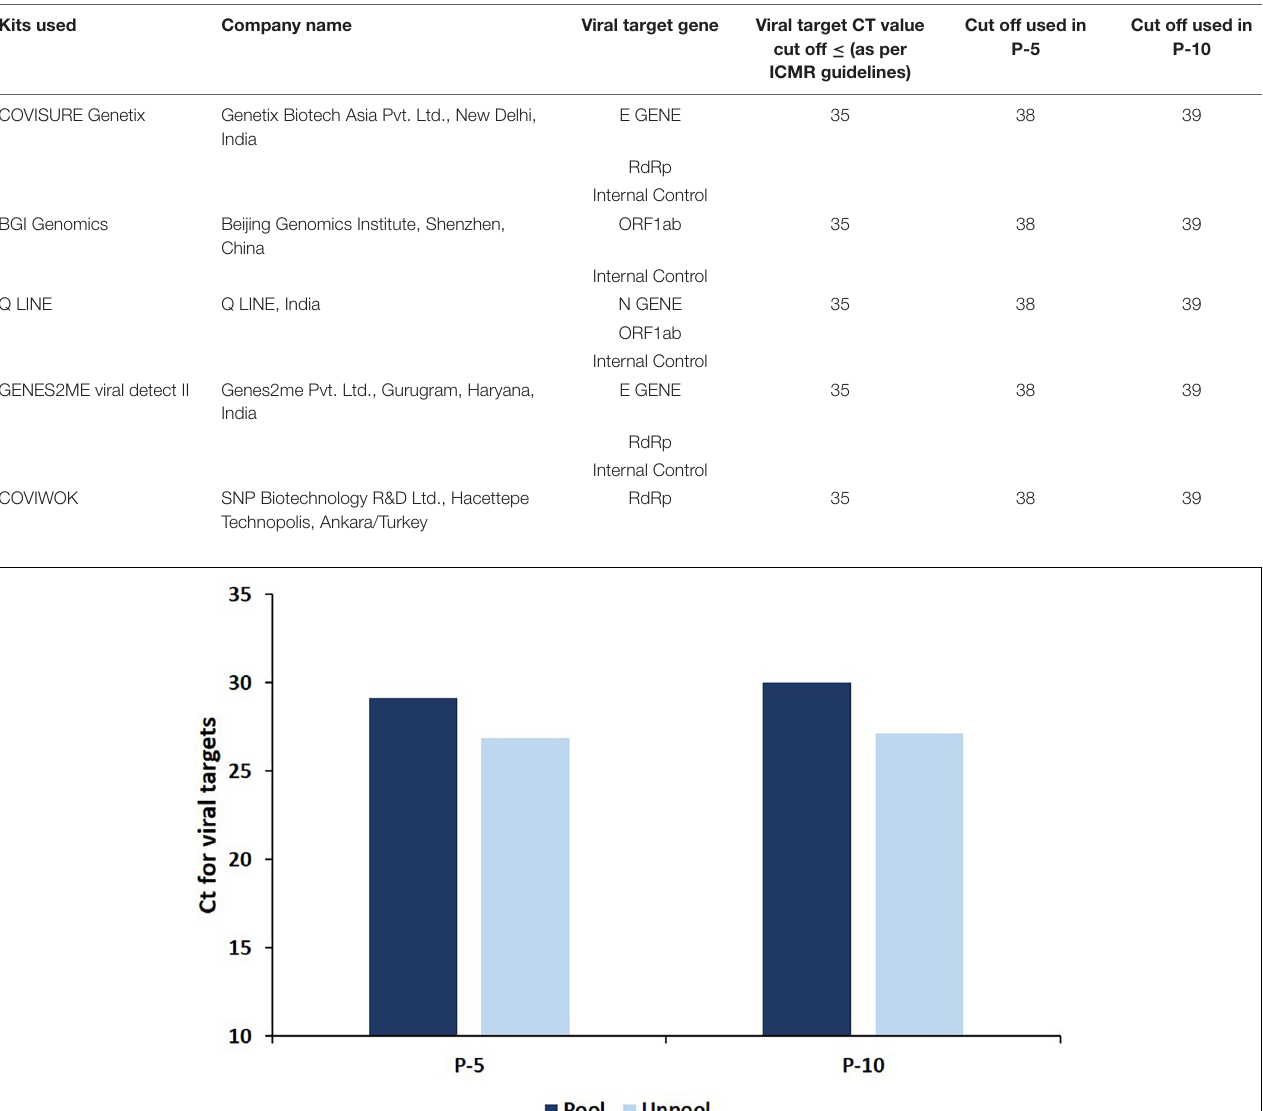
TABLE 1 | Details of the Kits used for RT-qPCR setup in diagnosis of the SARS-CoV-2. Kits used